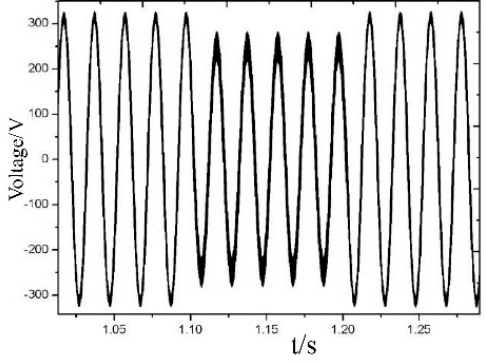
Figure 16. Waveform of voltage sag.